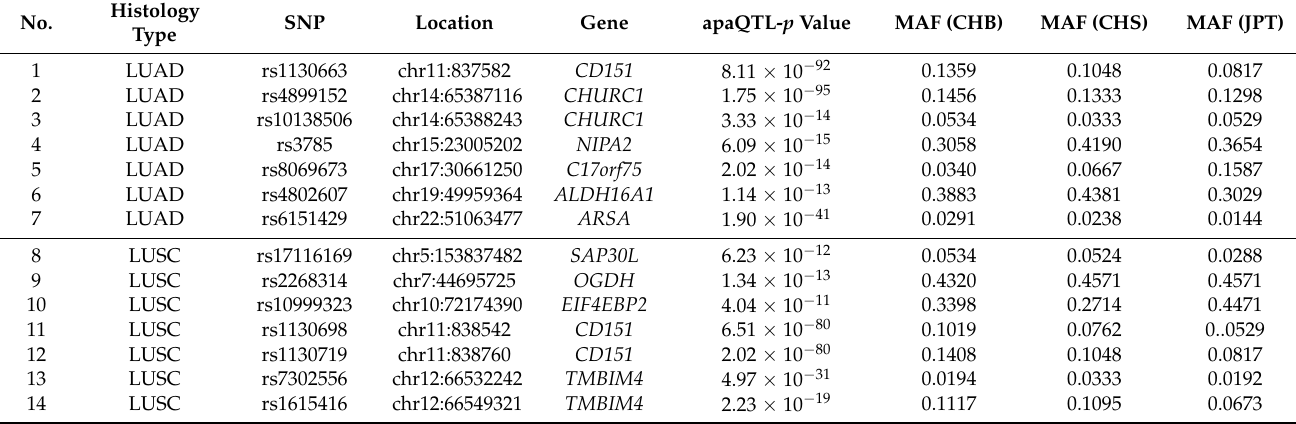
Table 2. Details information of 28 candidate